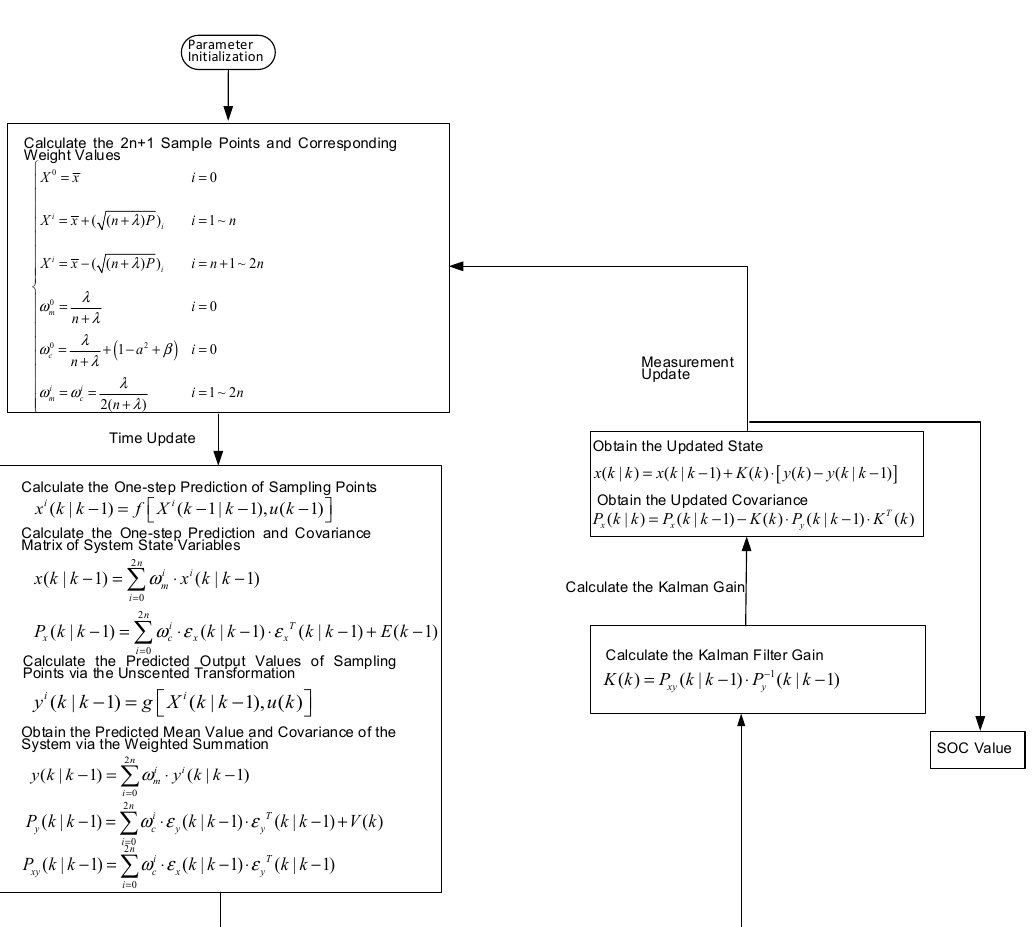
Figure 3. Essential operation steps of the unscented Kalman filtering algorithm.